Question: What visual encoding does this figure use to show its data?
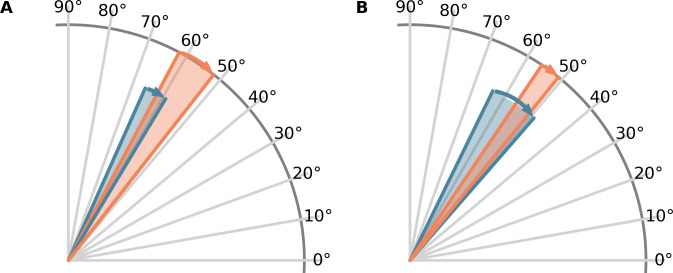
Answer: line